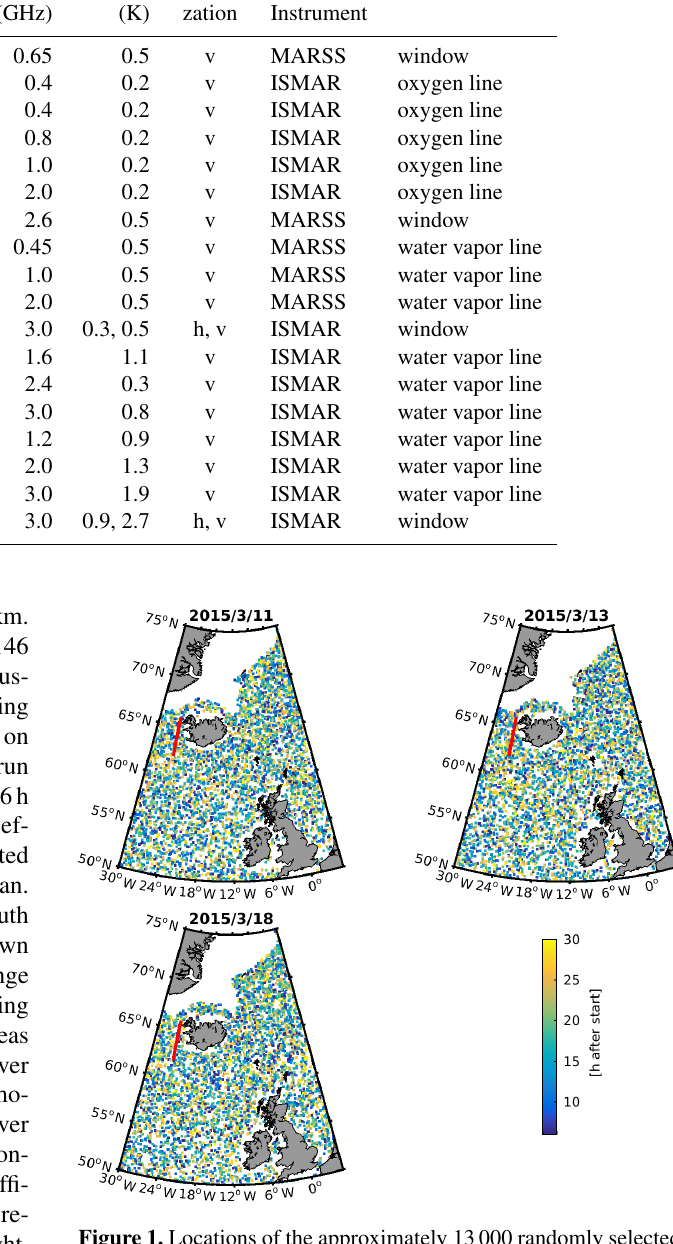
Figure 1. Locations of the approximately 13000 randomly selected profiles of the training database from the three ICON forecast runs on 11, 13, and 18 March 2015. Each dot stands for one profile. The day time of each profile is color indicated in hours after start of the runs. The red lines depict the north–south transects of the FAAM flight B897 on 18 March 2015. The white ocean areas north of Ice- land and east of Greenland indicate areas covered with sea